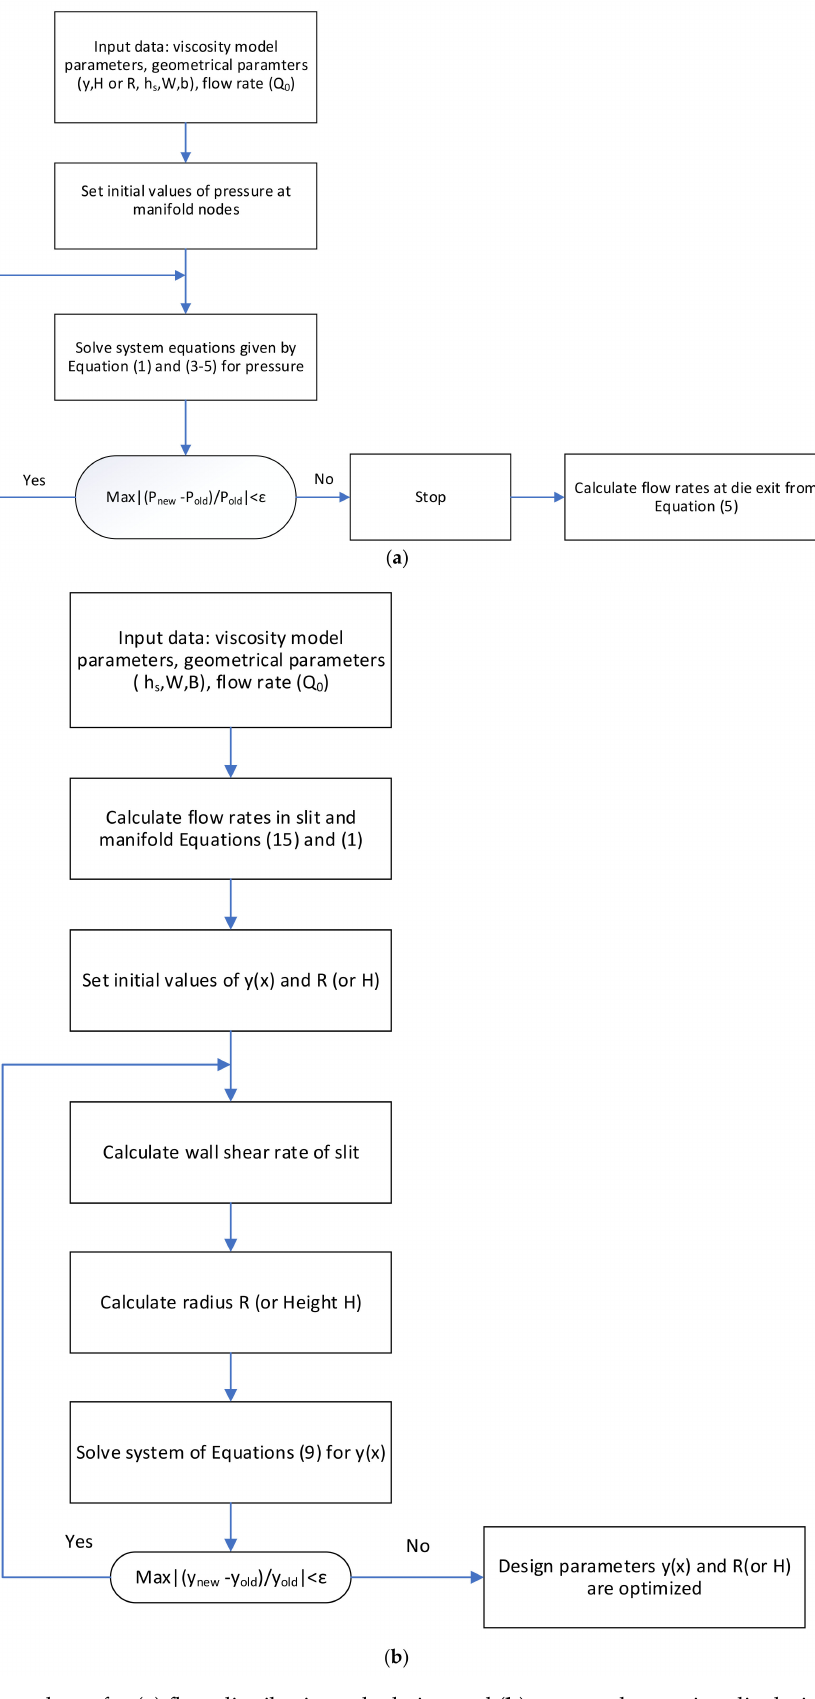
Figure 2. Flow charts for ( a ) flow distribution calculation and ( b ) proposed extrusion die design